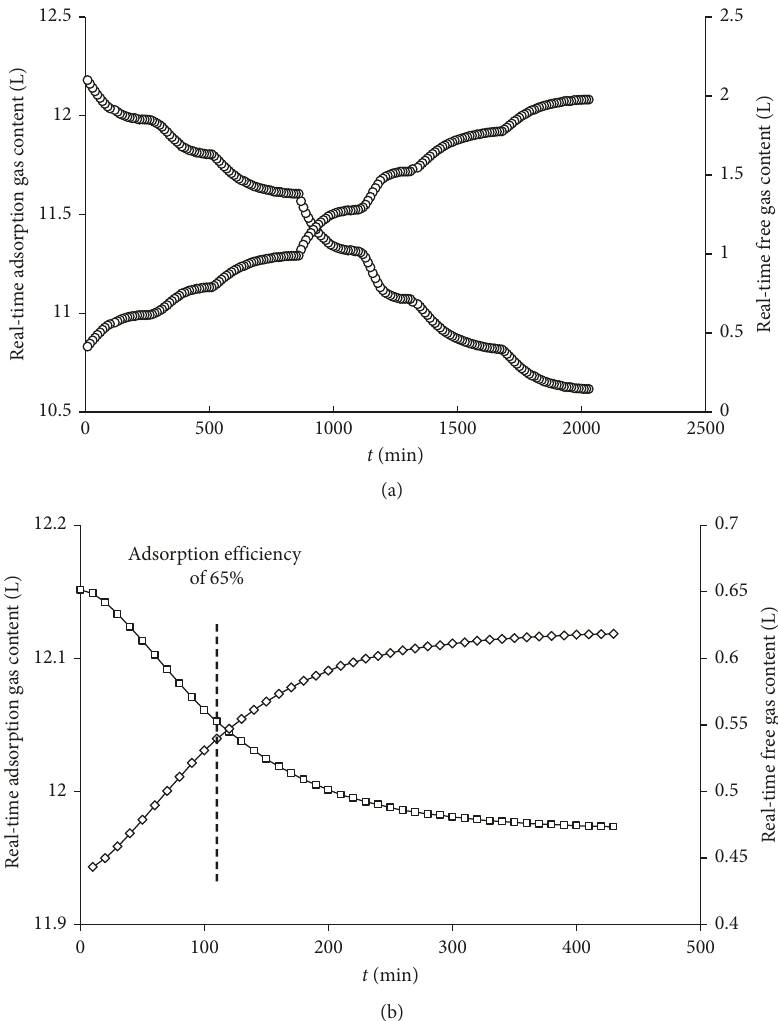
Figure 5: Real-time free gas and adsorption gas content evolution curves in the adsorption system of #1 coal with the initial free gas pressure of 0.445MPa. (a) Real-time free gas and adsorption gas content evolution curves ( V 0.445MPa at different temperatures. (b) Real-time free gas and adsorption gas content evolution curves ( V 30 ° C initial free gas pressure of 0.445MPa at 30 °